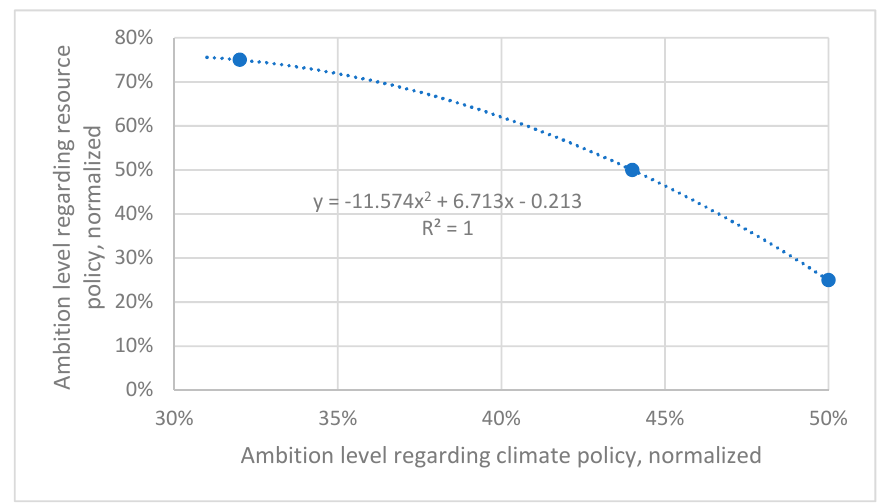
Figure 2. Trade-off between climate policy and resource policy in the policy package scenarios.